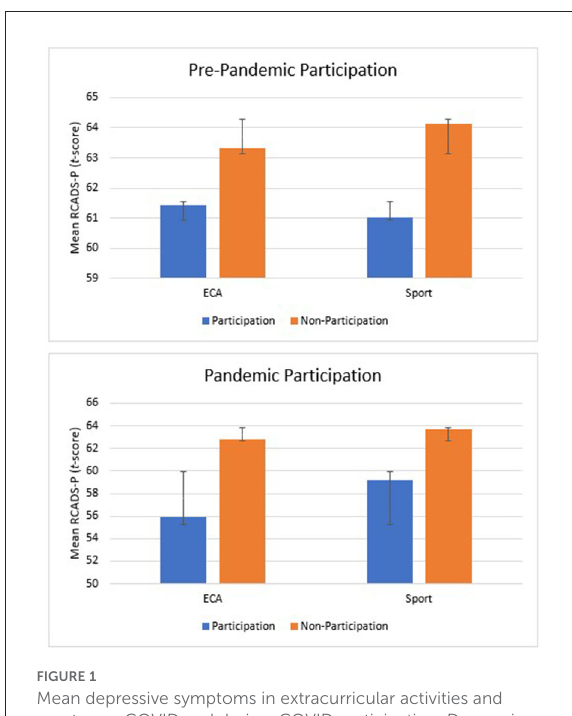
FIGURE1 Mean depressive symptoms in extracurricular activities and sports pre-COVID and during-COVID participation. Depressive symptoms were reported by parents though the RCADS-P (Revised Child and Anxiety Depression Scale-Parent Version); Error bars represent standard error.